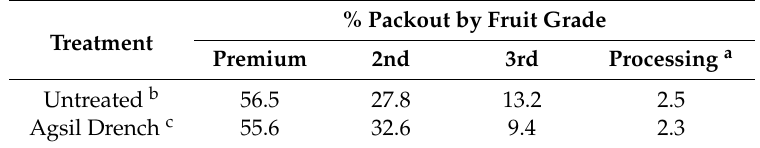
Table 7. Packout data collected August 2016 from Agsil amendment trial—Site 4, Comboyne.